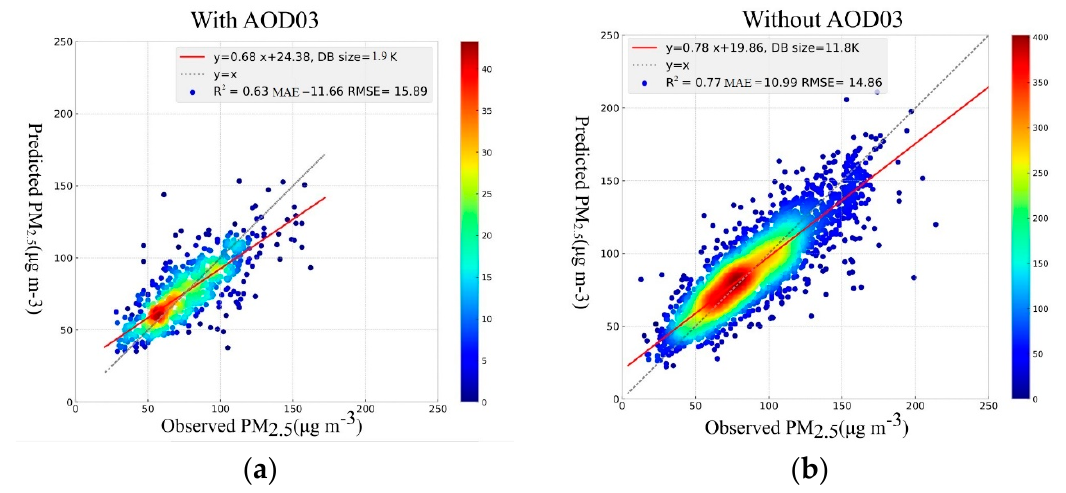
Figure 5. Scatter plot of predicted PM 2.5 versus observed values using the deep learning method. ( a ) Scatter plot of predicted vs. observed PM 2.5 including AOD03. ( b ) Scatter plot of predicted vs. observed PM 2.5 excluding the AOD03 variable. The line in red shows a linear regression between observed and predicted PM 2.5 values for the test dataset.